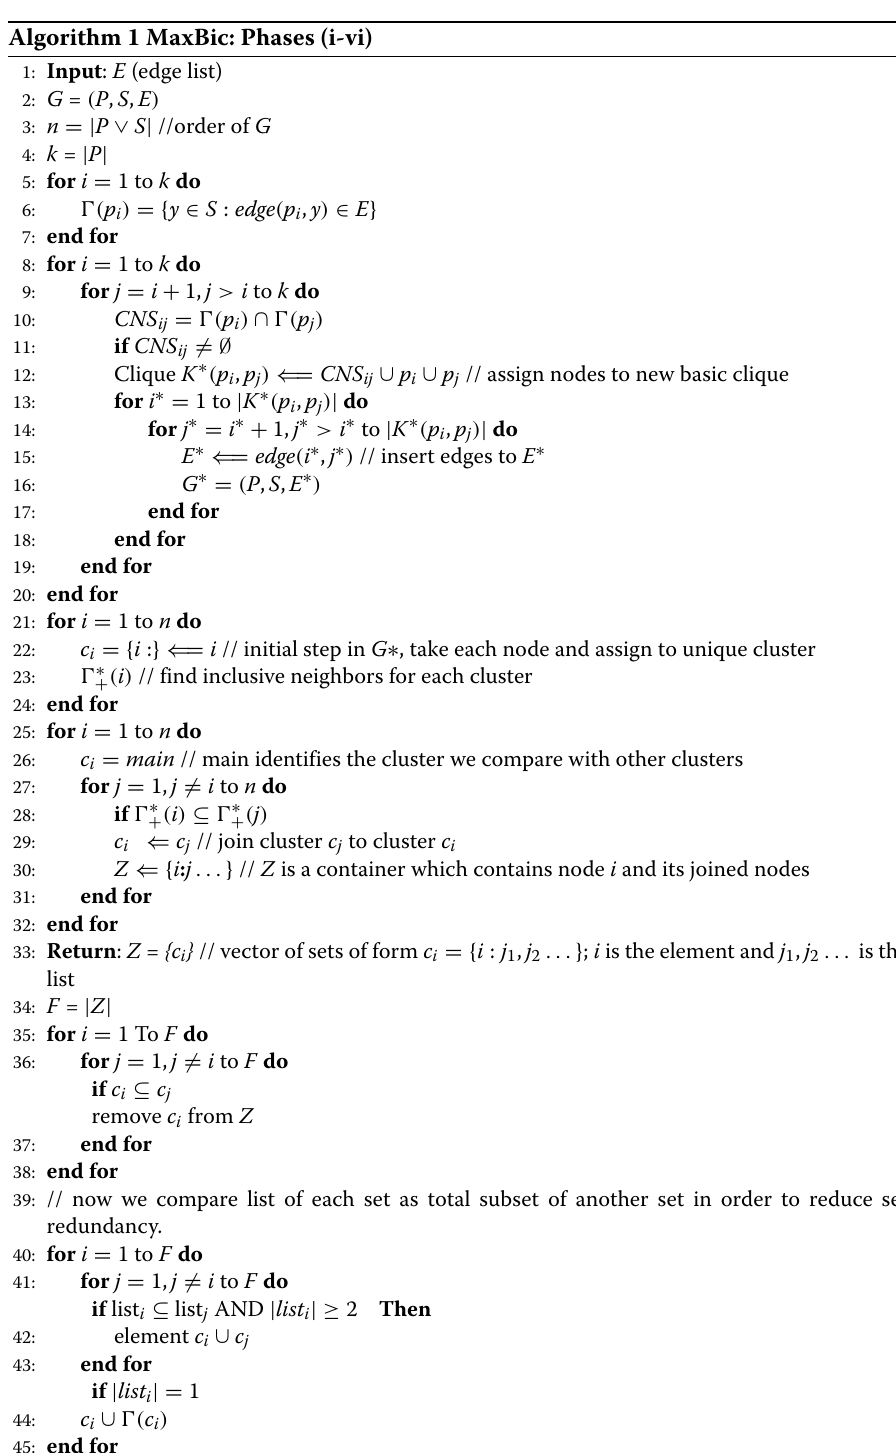
Algorithm 1 MaxBic: Phases